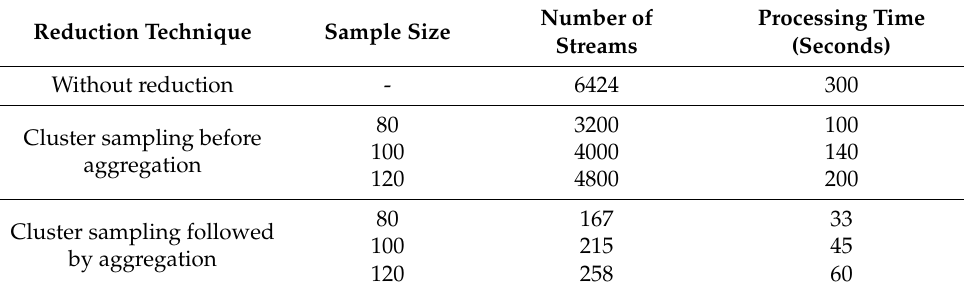
Table 8. Comparison of data reduction techniques for dataset